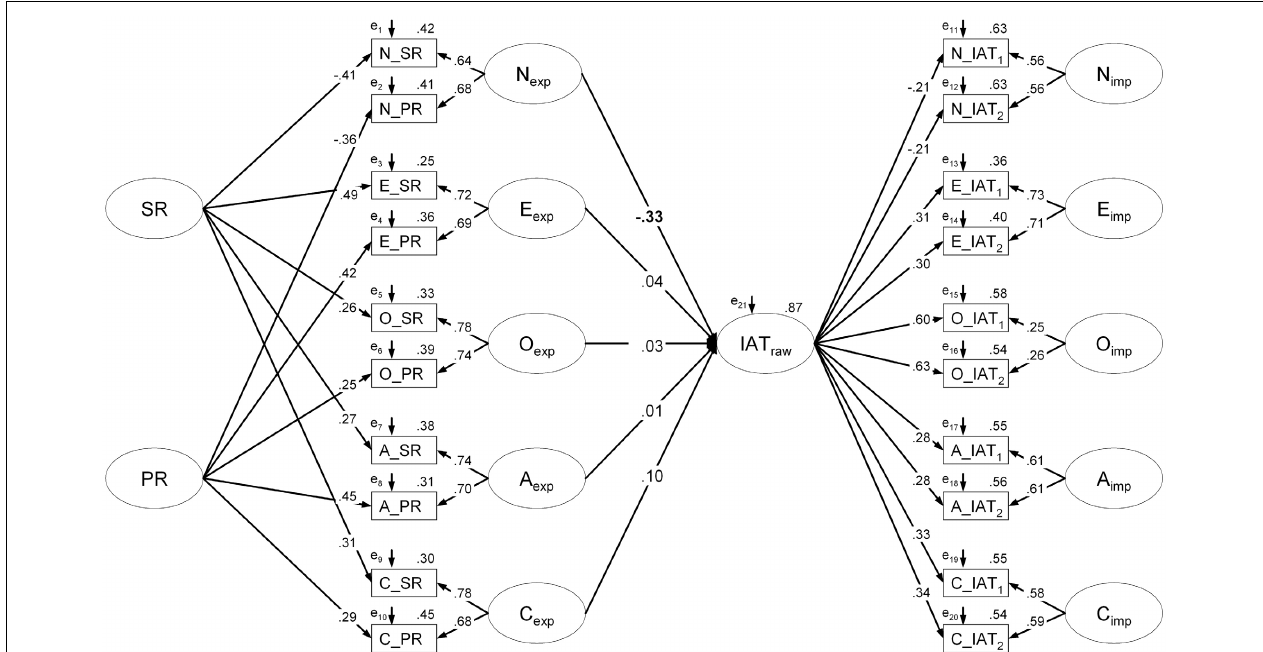
FIGURE 3 | Structural equation model with the IAT factor (IAT raw ) explaining variance in raw IAT scores. Parameter estimates are fully standardized. Note that for reasons of readability, intercorrelations among the latent personality factors are not